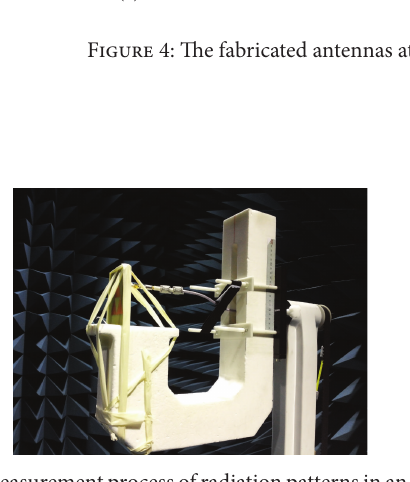
Figure 5: Measurement process of radiation patterns in an anechoic chamber.